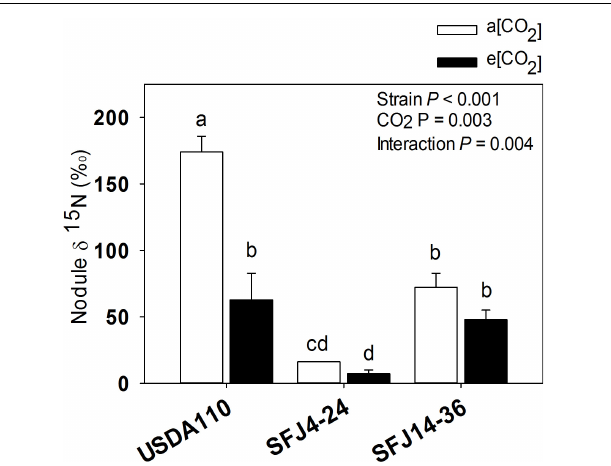
FIGURE 2 | Effect of [CO 2 ] on soybean nodule δ 15 N in plants inoculated with three different B. japonicum strains. Nodule 15 N isotope labeling ( δ 15 N, ) ± of soybean plants grown at a[CO 2 ] (400 ppm) and e[CO 2 ] (700 ppm) and inoculated with three Bradyrhizobium japonicum strains (USDA110, (cid:104) SFJ4-24, and SFJ14-36). Bars correspond to the mean ± SE of n = 3. Results of statistics are shown (two-way ANOVA, P < 0.05). Different letters indicate significant differences (Tukey post hoc test P < 0.05).